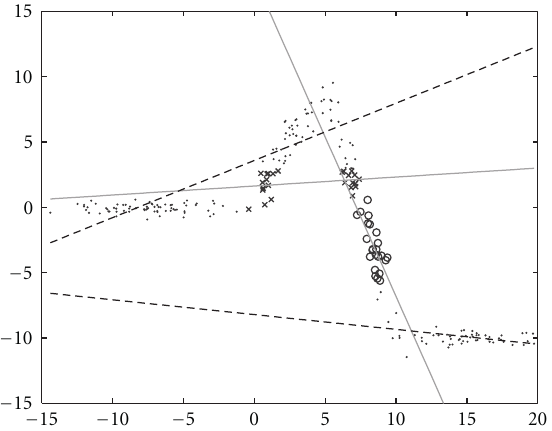
Figure 10: Approximation of the toy function (17) using the ANFIS network obtained by the HHCS procedure with 4